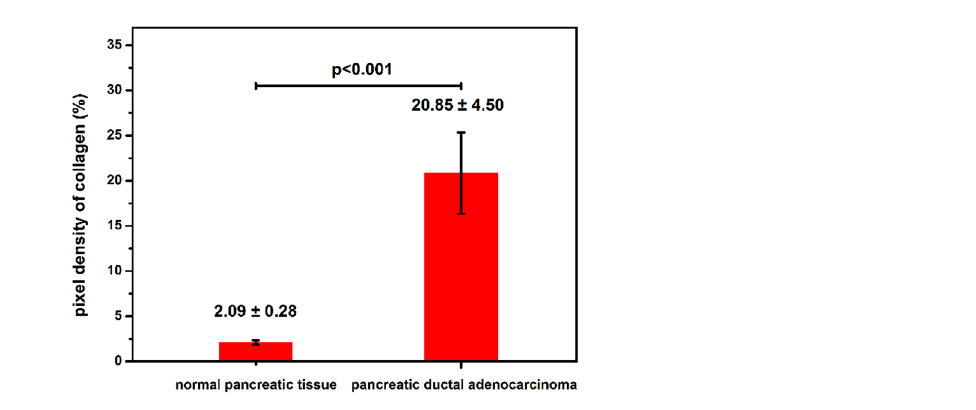
Figure 5. Pixel density of collagen in normal pancreatic tissue and pancreatic ductal adenocarcinoma (n = 8, p <